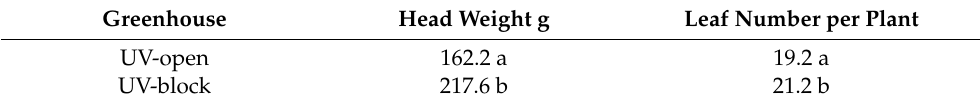
Table 6. The effect of greenhouse cover transparency in UV-A radiation on head weight and leaf num- ber per plant in red lettuce (Redino Lollo rosso), 25 days after transplanting, in the second experiment. Greenhouse Head Weight g Leaf Number per Plant UV-open 162.2